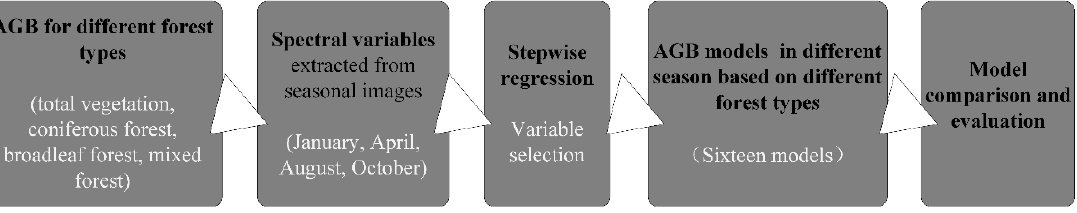
Figure 2. The workflow for aboveground biomass (AGB) models derived from different scenarios.